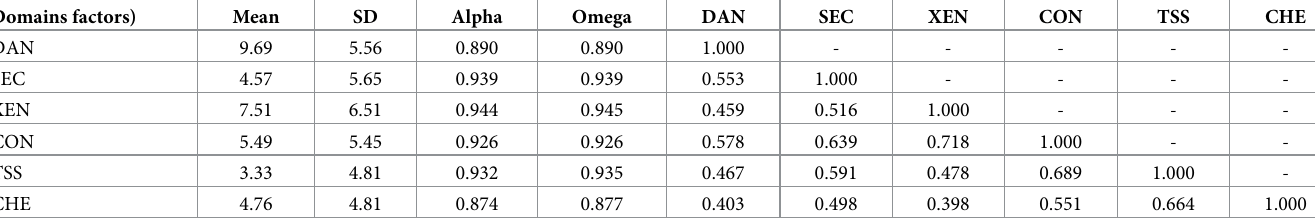
Table 2. Average values, Cronbach’s alpha and correlation coefficients between